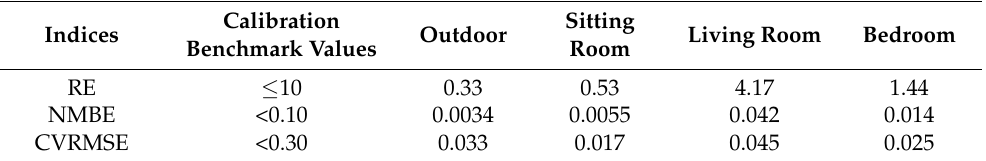
Table 8. Values of validation